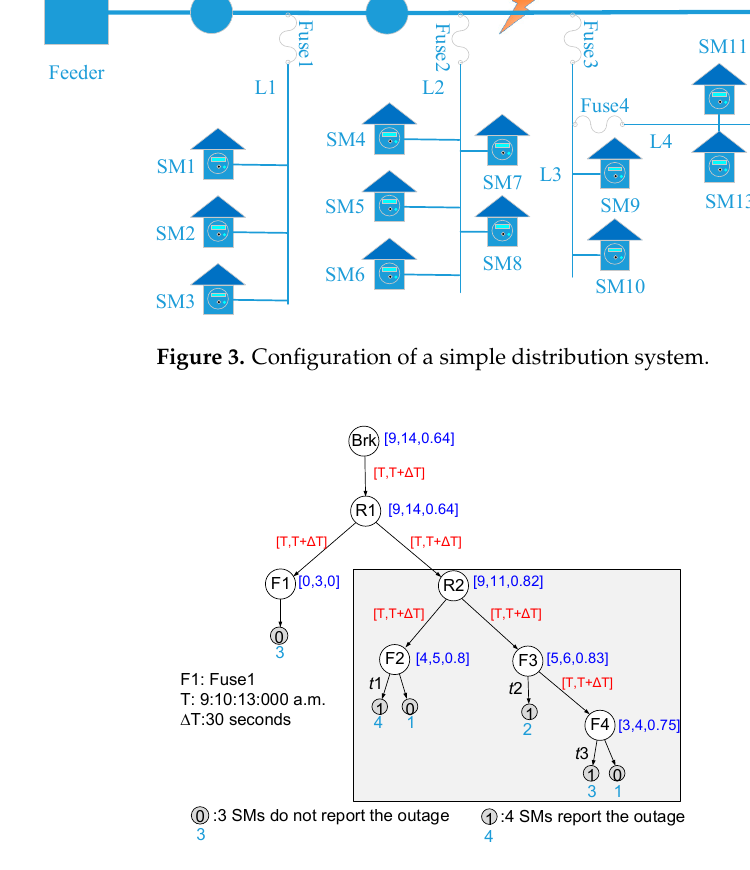
Figure 4. Temporal Causal Diagram (TCD) for outage management.